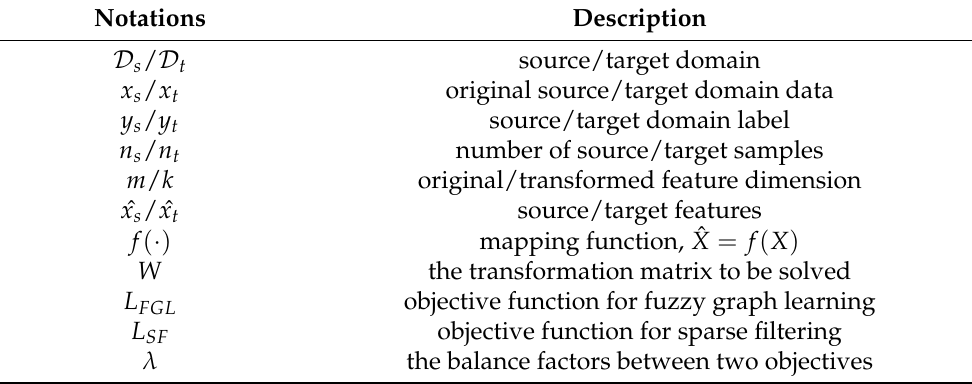
Table 1. Notations and descriptions used in this